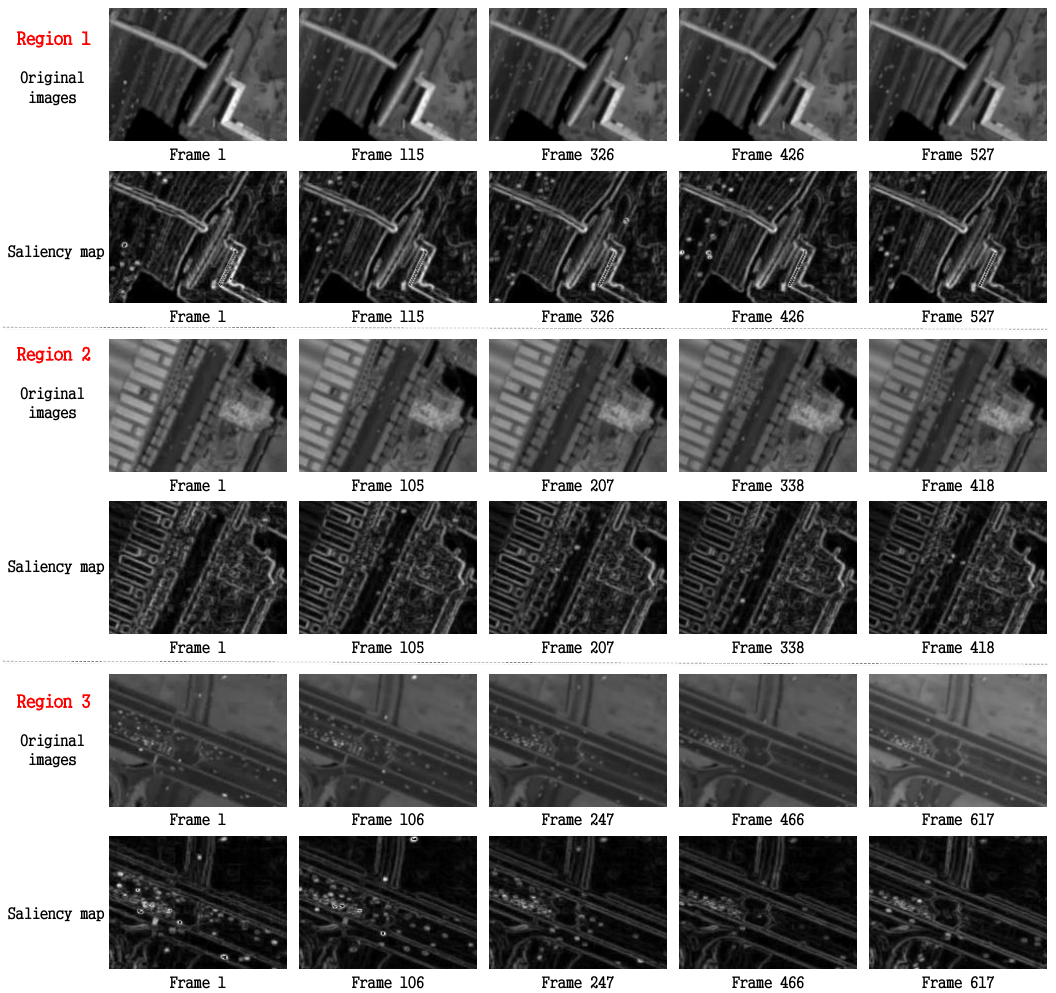
Figure 6. The comparison between grayscale original image and saliency map of the same region. Three regions are selected, and for each regions, two rows are displayed. For each regions, the first rows show the original image sequence of the region and the second rows show the saliency map of the